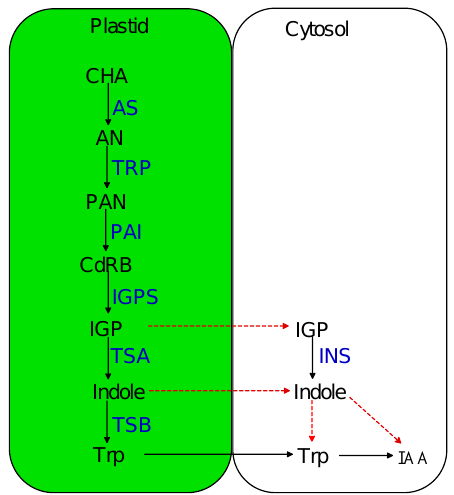
Figure 1. The plastidal and cytosolic pathways of indole production in plants. CHA, chorismate; AS, anthranilate synthase; AN, anthranilate; TRP, phosphoribosyl anthranilate transferase; PAN, 5-phosphoribosylanthranilate; PAI, phosphoribosyl anthranilate isomerase; CdRB; 1-(o-carboxyphenylamino)-1-deoxy-ribulose 5-phosphate; IGPS, indole-3-glycerol phosphate synthase; IGP, indole-3-glycerol phosphate; TSA, tryptophan synthase α subunit; TSB, tryptophan synthase β subunit; INS, indole synthase. Dotted lines denote unconfirmed reactions.